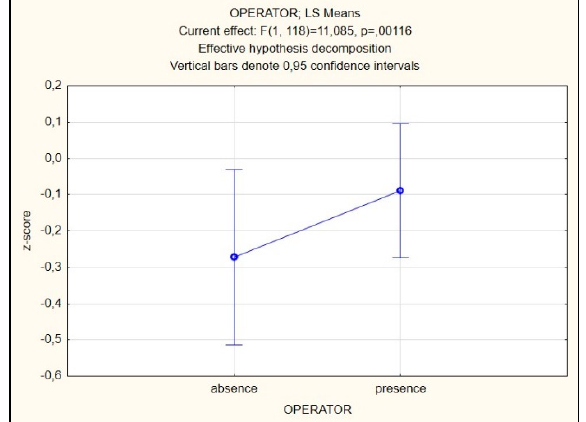
Figure 17. Strategy post hoc results (Italian) .